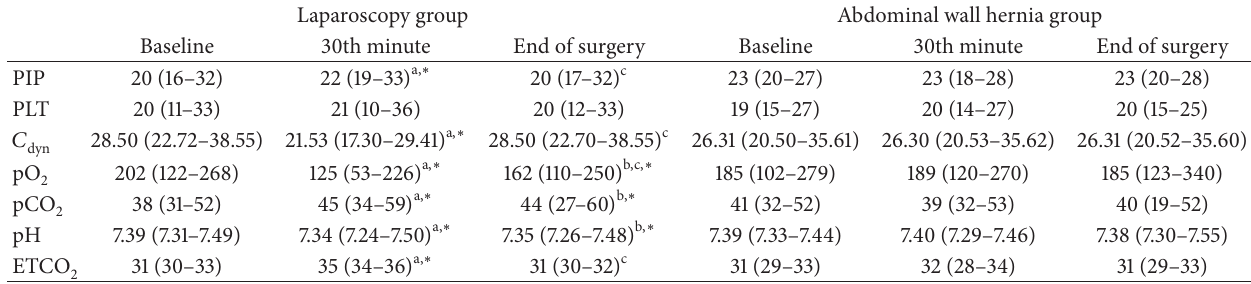
Table 2: Pre- and perioperative levels of respiratory parameters and measurements of AKG in patients who underwent laparoscopic cholecystectomy and abdominal wall